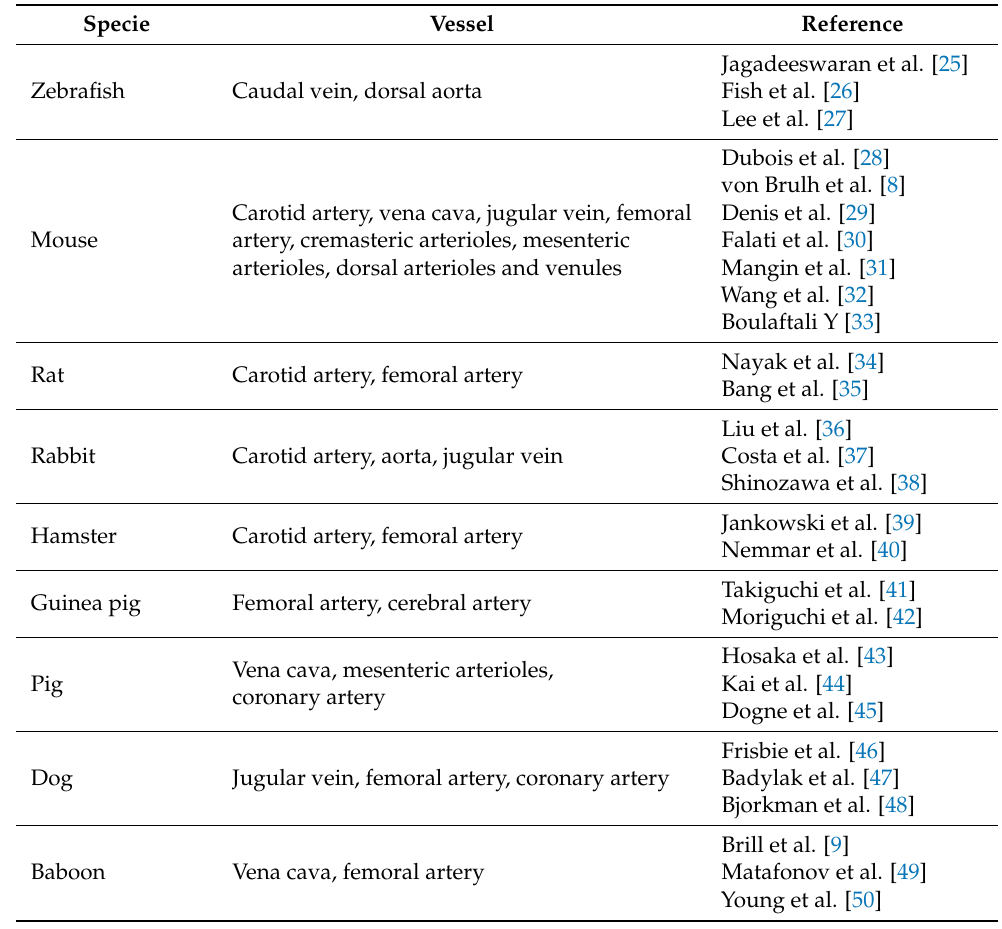
Table 1. Summary of species and vascular beds used in thrombosis